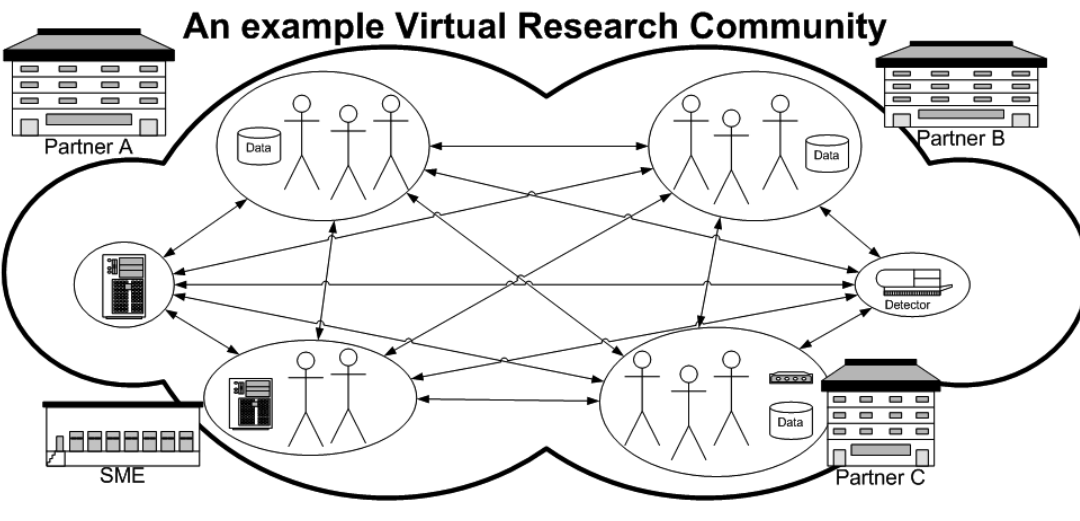
Figure 1. Example of a virtual research community. Image source: Figure 1 of